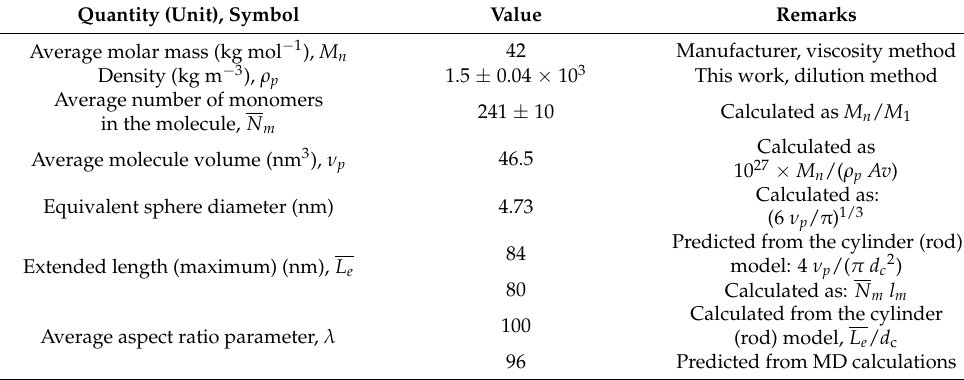
Table 4. Physicochemical characteristics of P-Arg used in experimental studies, T = 298 K, pH 5.4–5.8. Quantity (Unit), Symbol